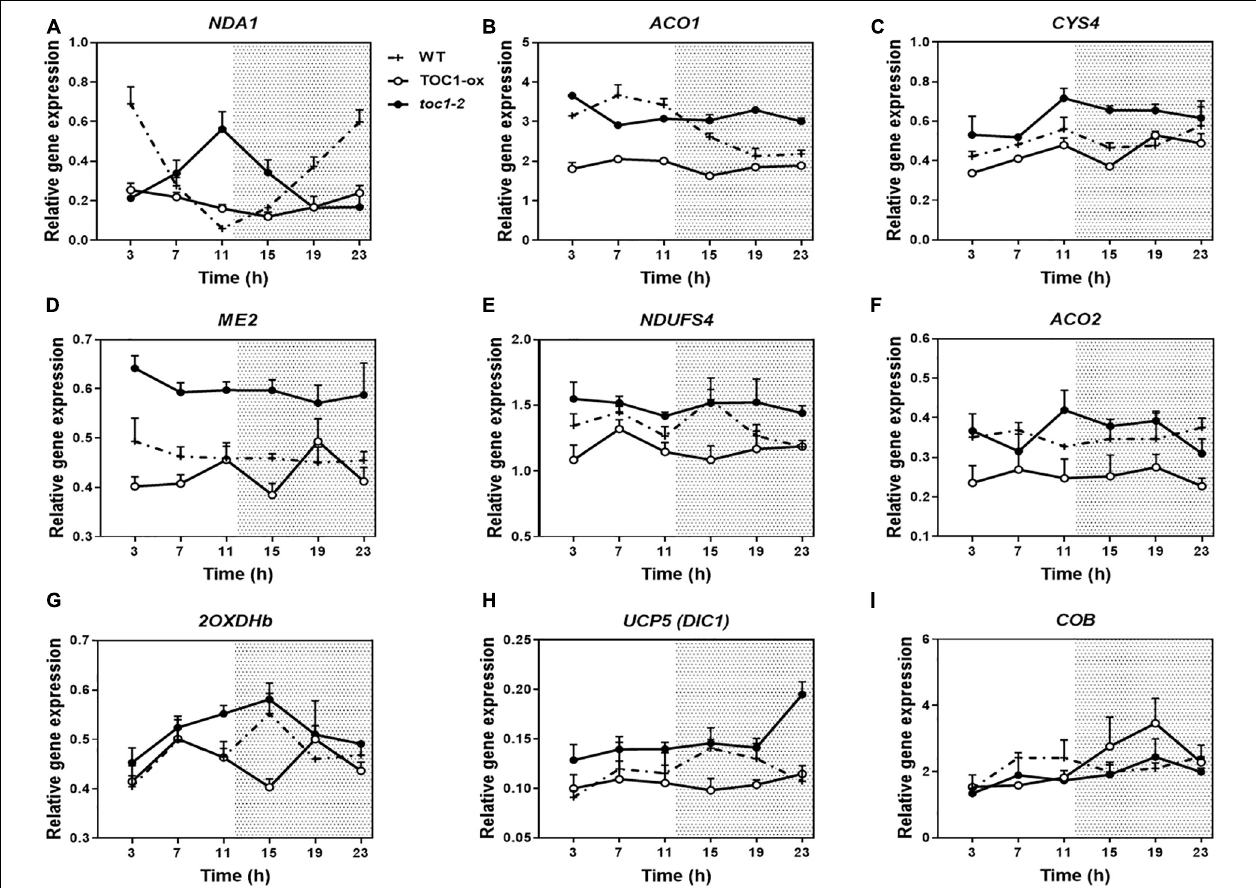
FIGURE 2 | Miss-expression of mitochondrial-related genes in TOC1-ox and toc1-2 mutant plants. Time course analyses of mitochondrial-related gene expression in WT, TOC1-ox and toc1-2 plants over a circadian cycle. Plants were entrained under LD cycles and transfer for 2 days under LL conditions. Expression of (A) NDA1 , (B) ACO1 , (C) CITRATE SYNTHASE 4 ( CYS4) , (D) NAD-DEPENDENT MALIC ENZYME 2 ( ME2 ), (E) NADH:UBIQUINONE OXIDOREDUCTASE FE-S PROTEIN4 (NDUFS4) , (F) ACONITASE 2 ( ACO2) , (G) 2-OXOGLUTARATE DEHYDROGENASE E1-2 ( 2OXDHb) , (H) DICARBOXYLATE CARRIER 1 ( UCP5/DIC1) and (I) CYTOCHROME B (COB) . Relative expression was obtained by RT-Q-PCR analyses. Data are represented as the mean + SEM. The white and dotted areas in represent subjective day and subjective night, respectively. Three biological replicates were performed for all experiments, with plants grown independently, and with samples collected, processed and analyzed at different